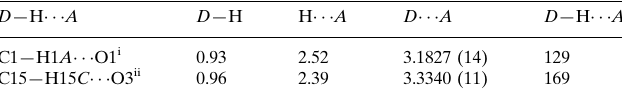
Data collection Bruker APEXII CCD area-detector diffractometer Absorption correction: multi-scan ( SADABS ; Bruker, 2005) T min = 0.872, T max = 0.951